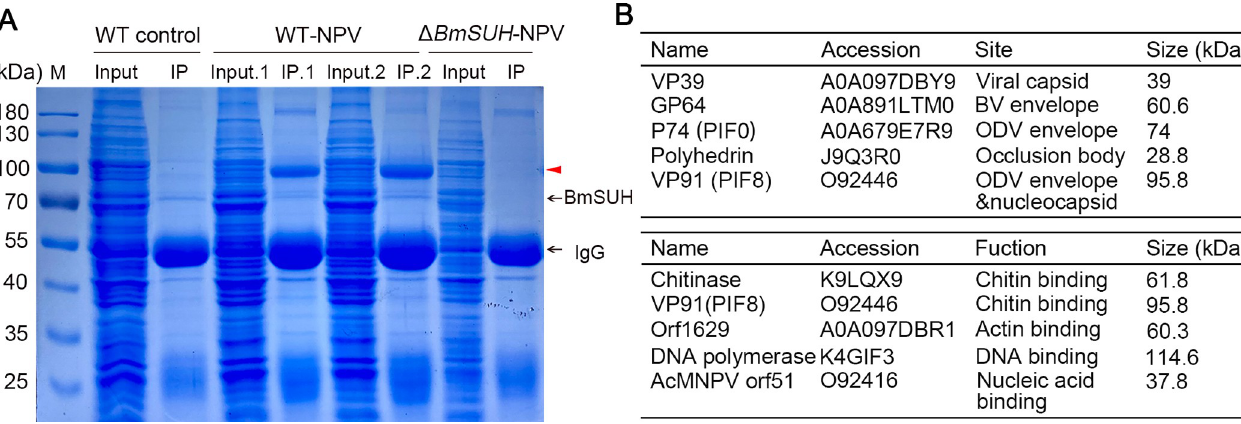
Fig 5. Identification of BmSUH interacting proteins by LC-MS/MS analysis of endogenous CO-IP products. (A) SDS-PAGE gel image of samples after endogenous BmSUH immunoprecipitation. Whole-cell lysates of midgut tissue were used for immunoprecipitation (IP) with anti-BmSUH. The red triangle represented the specific bands. (B) Viral proteins detected by LC-MS/MS in 70 kDa and 100 kDa gels. The structural proteins of BmNPV were shown in the upper graph and the proteins that belonged to the functional categories of “binding” in GO analysis were showed in the lower graph. IP.1: the IP sample at 72 hpi; IP.2: the IP sample at 96